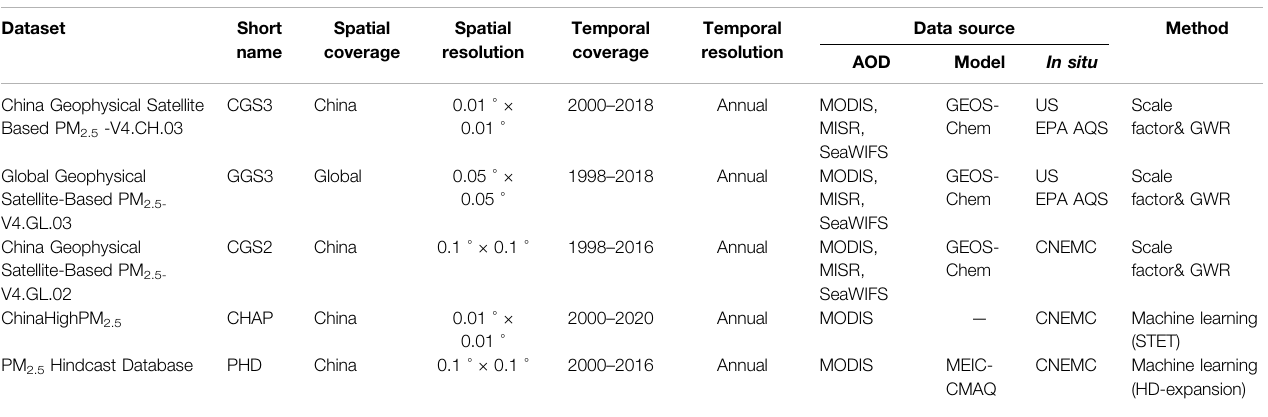
TABLE 1 | Five sets of PM 2.5 datasets in